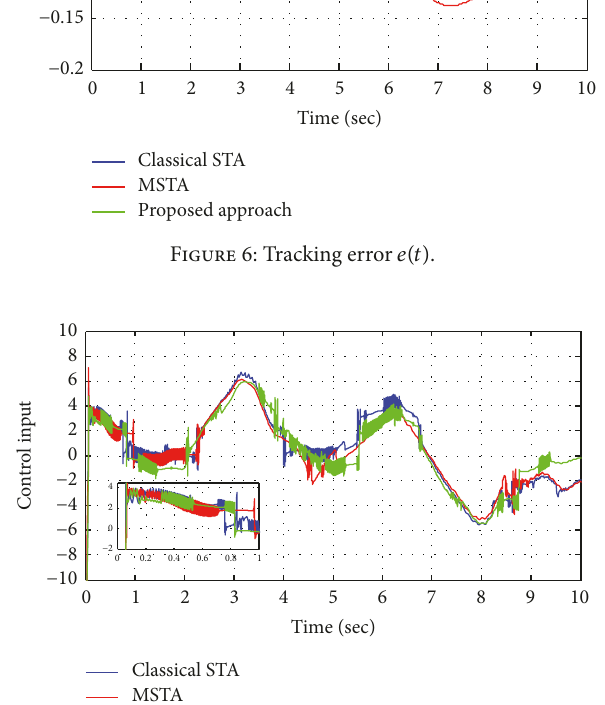
Figure 7: Control inputs 𝑢(𝑡) for pendulum system.